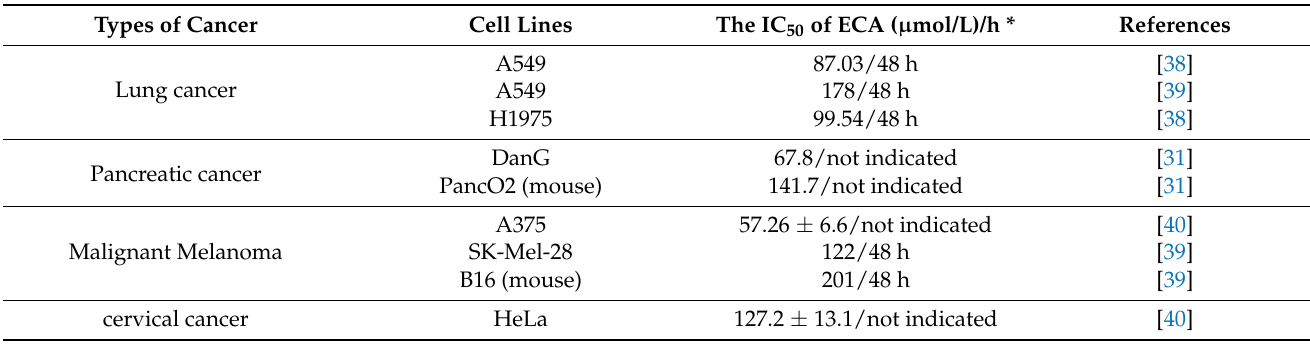
Table 1. Half-maximal inhibitory concentration (IC 50 ) of ECA in different human and mouse tumor cell